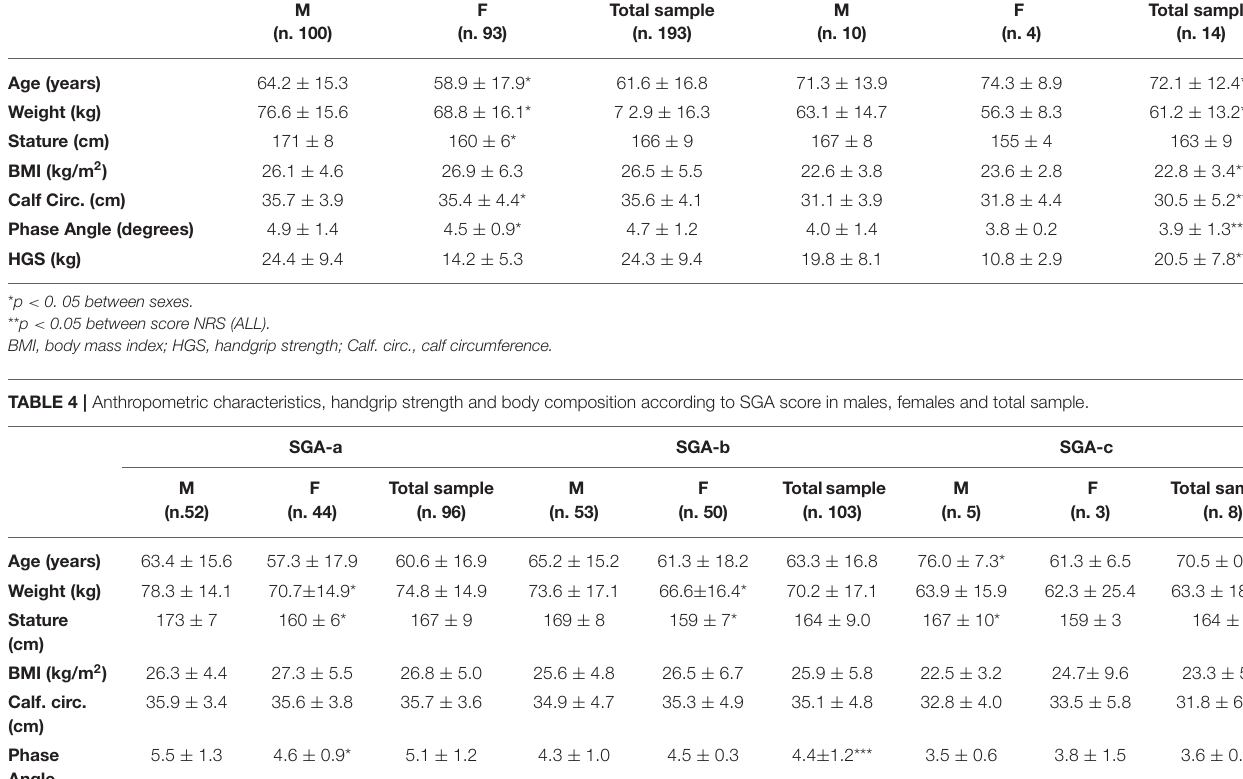
NRS < 3 NRS ≥ 3 M F Total sample (n. 100) (n. 93) (n. 193)